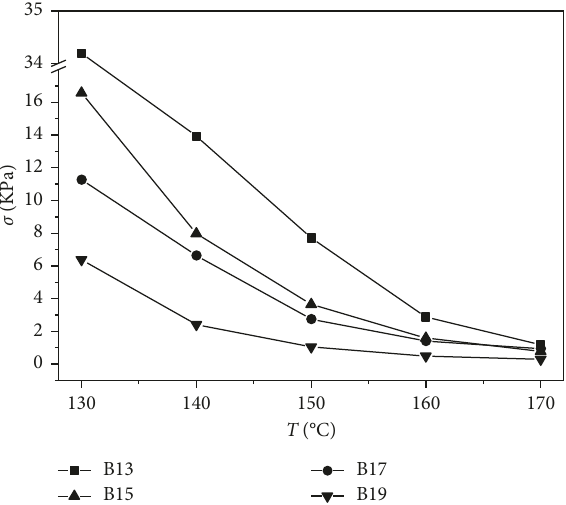
Figure 5: Temperature dependencies of feedstocks viscosity at the 1 shear rate of 1000s − 1 . From Figure 6, the typical −